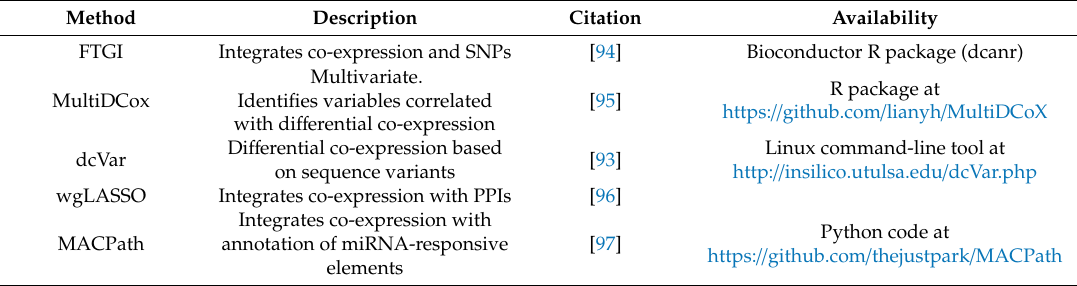
Integrates co-expression with annotation of miRNA-responsive